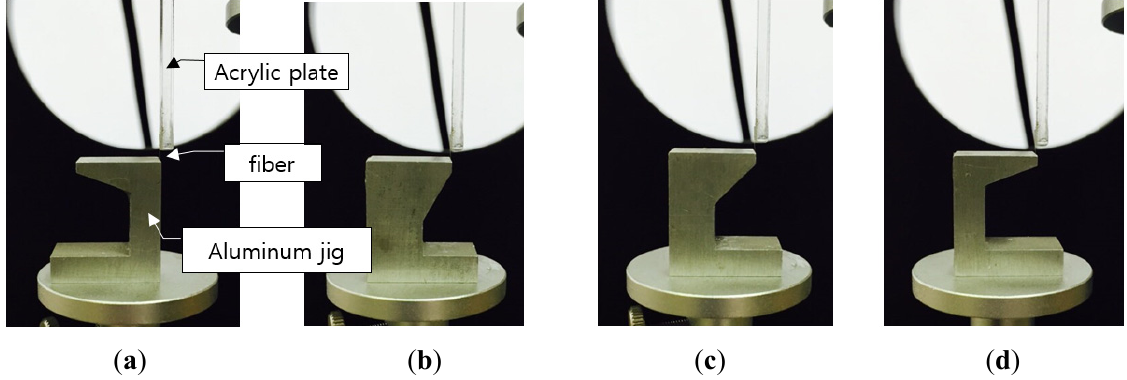
Figure 3. Test setup for measuring fiber tensile strength according to fiber orientation: ( a ) 0 ˝ ; ( b ) 30 ˝ ;